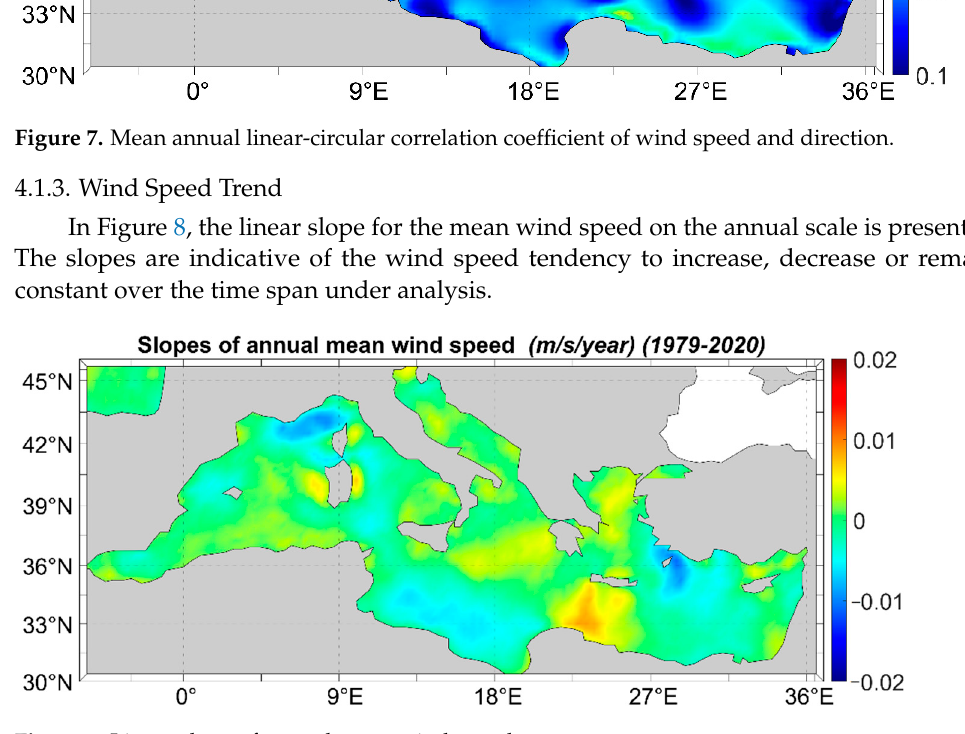
Figure 8. Linear slope of annual mean wind speed.